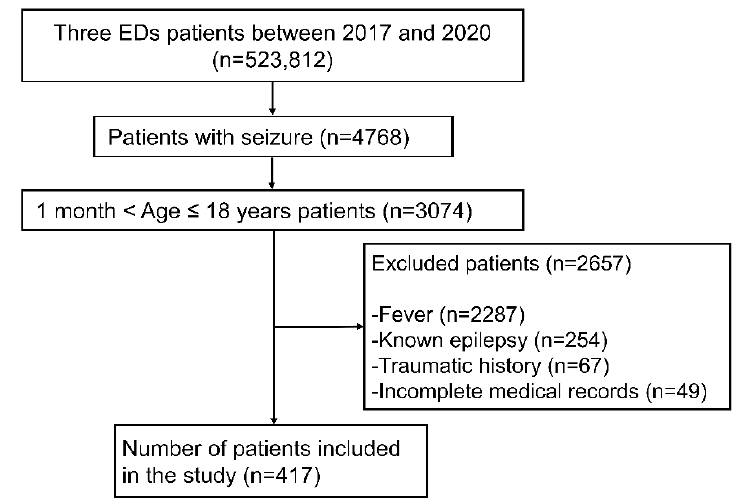
Figure 1. Flow chart of patient selection. ED, emergency department.